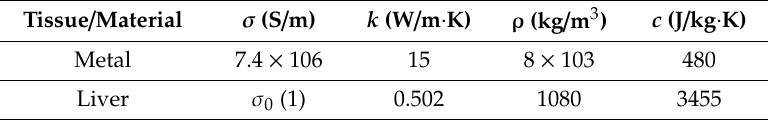
Table 1. Characteristics of the materials used in the study [5–7].